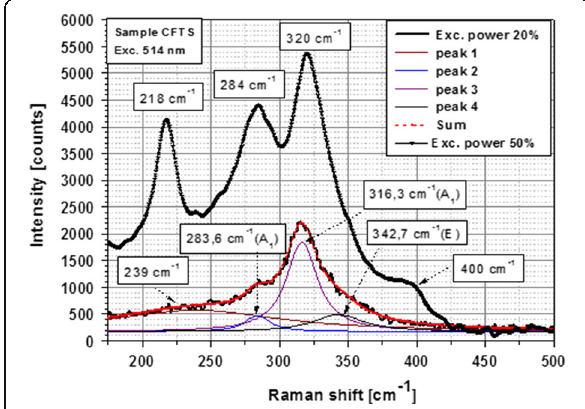
Fig. 2 Raman spectrum measured at 20 and 50% excitation maximum laser power and fitting of the spectrum (20%) with the Lorentzian